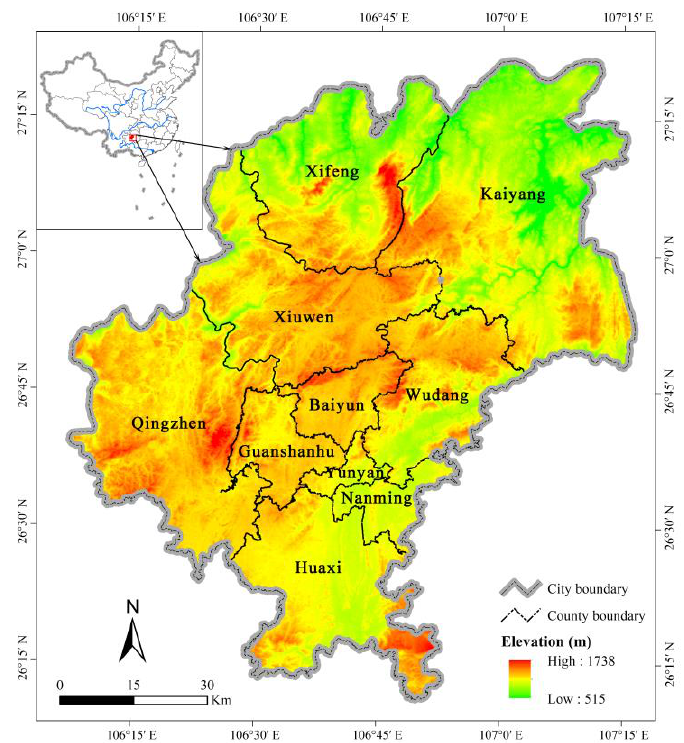
Figure 1. Location of Guiyang City.